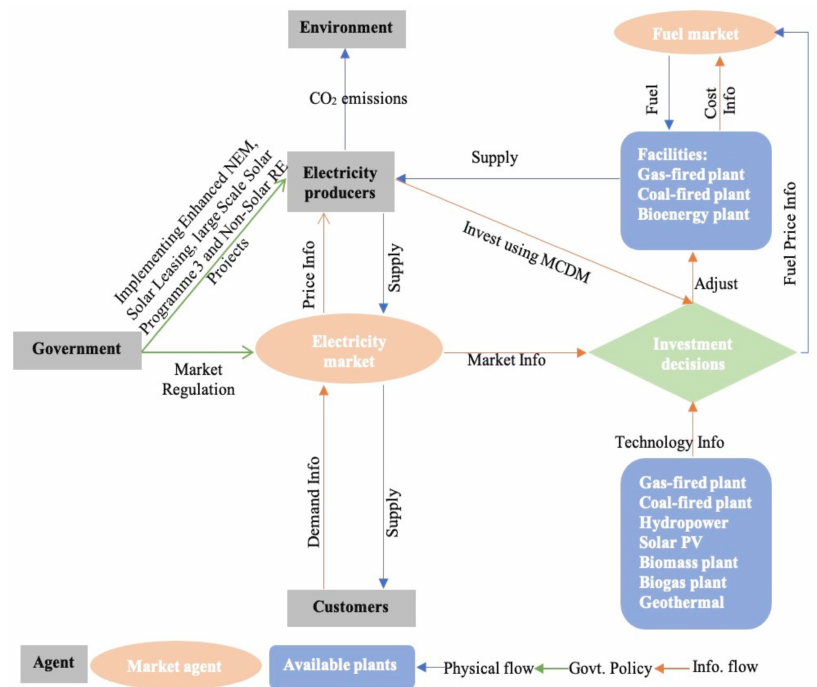
Figure 1. Model structure: There are six different kinds of agents in our concept. Rectangles represent agents, and ovals represent two markets. The physical movement of goods (fuel inputs and energy), as well as CO 2 emissions, are indicated by the blue arrows. The flow of cost and price information, governmental actions, and investment decisions by electricity producers are represented by peach arrows. Government agents oversee the electricity market and create rules. Based on legally binding contracts from the electricity market, energy producers buy fuel from the global market and ensure a steady electricity supply to the market. After the generation phase, emissions are discharged into the atmosphere, and producers determine whether it is necessary to shut down power plants or build new ones. If it is decided to build a new one, the producer uses the multi-criteria decision making (MCDM) technique to choose the preferred power plant. Finally, the customer receives electricity from the electrical market. In conclusion, the first rounded blue rectangular box displays different types of electricity generation plants that are now accessible in Malaysia. In contrast, the last blue round box lists the carbon-emitting generating